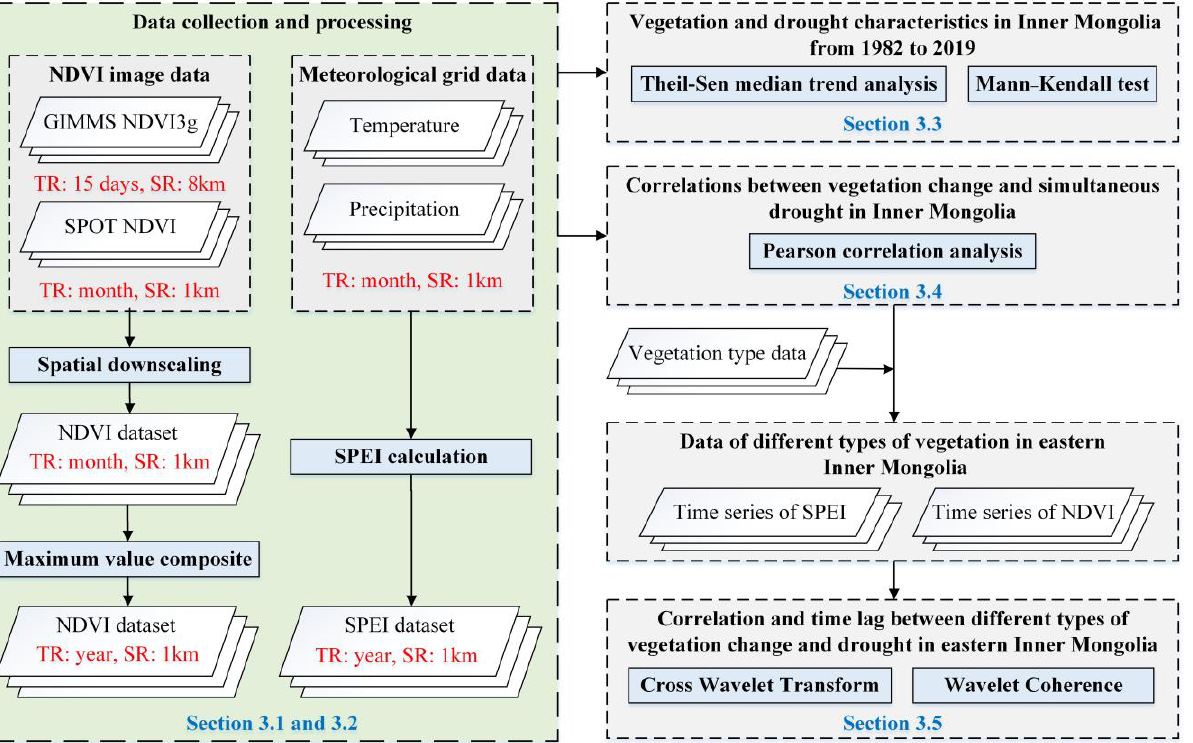
Figure 2. Flowchart of the methods used in this study. In the figure, TR represents temporal resolution and SR represents spatial resolution. Parallelograms represent datasets and rectangles represent research methods.